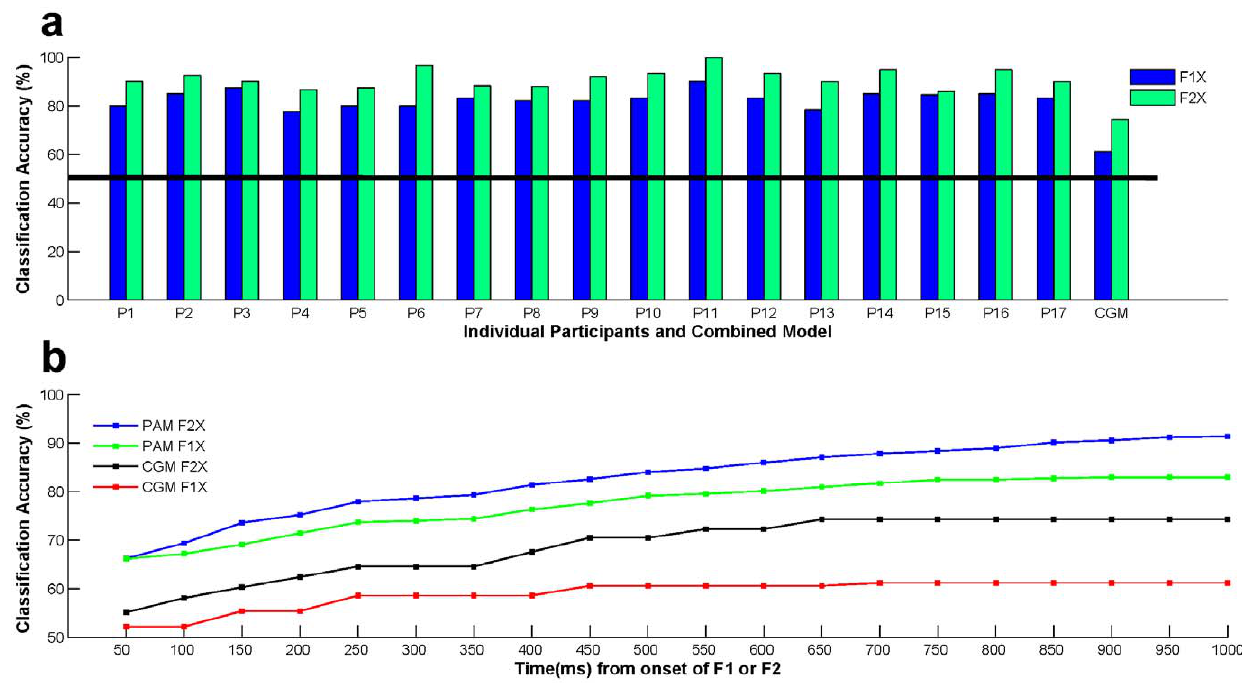
Figure 1. Classification accuracy at individual and combined level. ( a ) Prediction performance of the classifier at individual level (PAM; P i indicates i -th Participant) and at combined level (CGM). Blue and green bars represent classifier accuracy based on brain responses related to the first face (F1X) and second face (F2X), respectively. Prediction accuracy was higher at individual level than at combined level, and also higher for F2X than F1X. Chance level is at 50% (black horizontal line). (b) Classifier performance for PAM and CGM analysis for both F1X and F2X with respect to time. The classifier performance gradually increased till 700 ms especially for CGM.